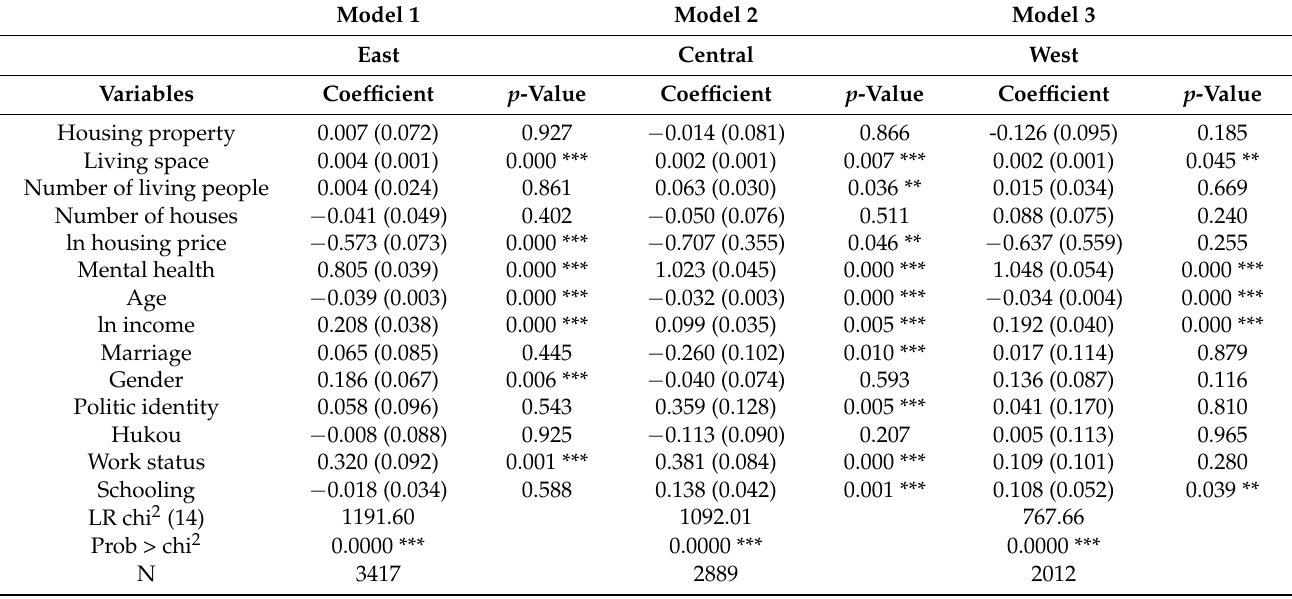
Table 3. Results for the impact of housing on self-rated health by region